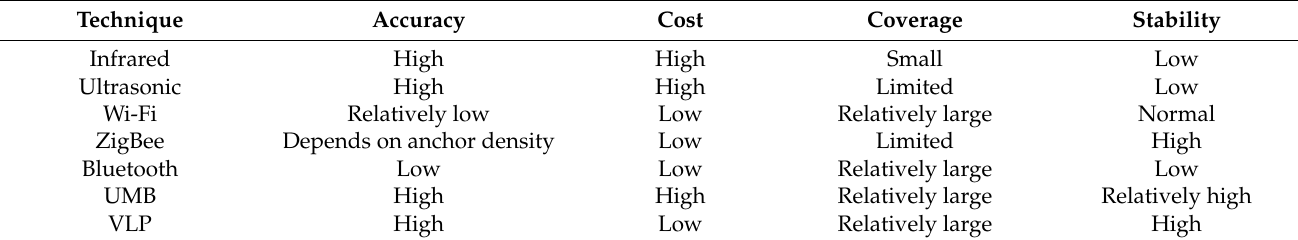
Table 1. Comparative analysis of classical indoor positioning techniques.